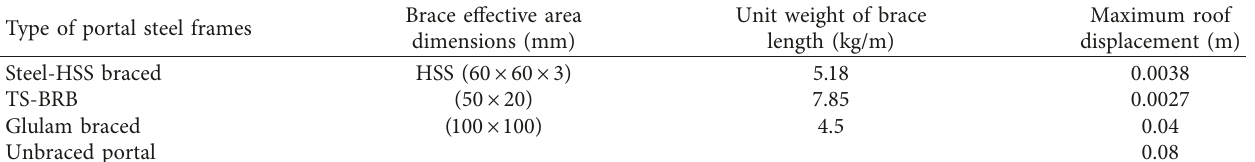
Table 13: Summery of maximum roof displacement history under selected record of different frames.